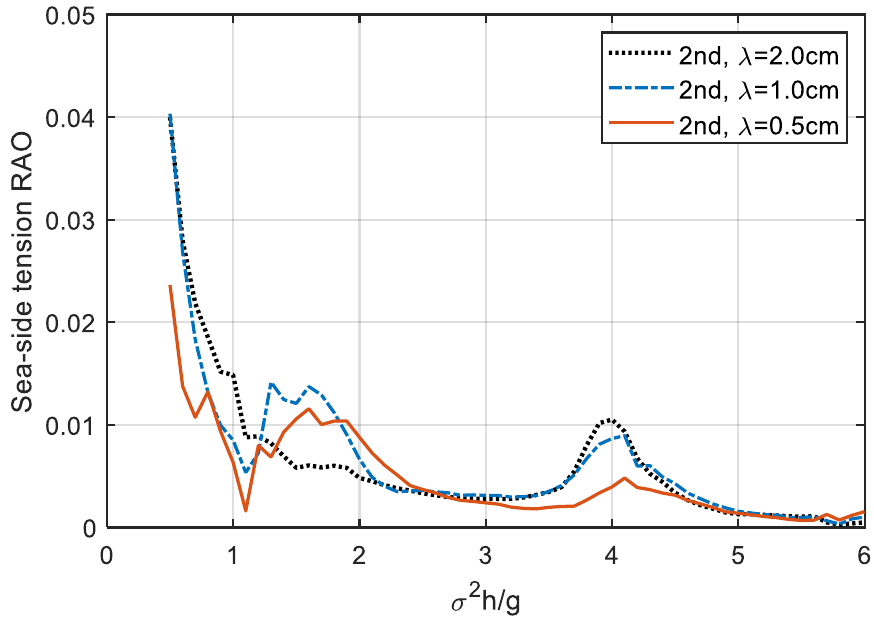
Figure 15. Comparison of the second-order sea-side tension RAO of the floating platform with different fishnet mesh sizes.